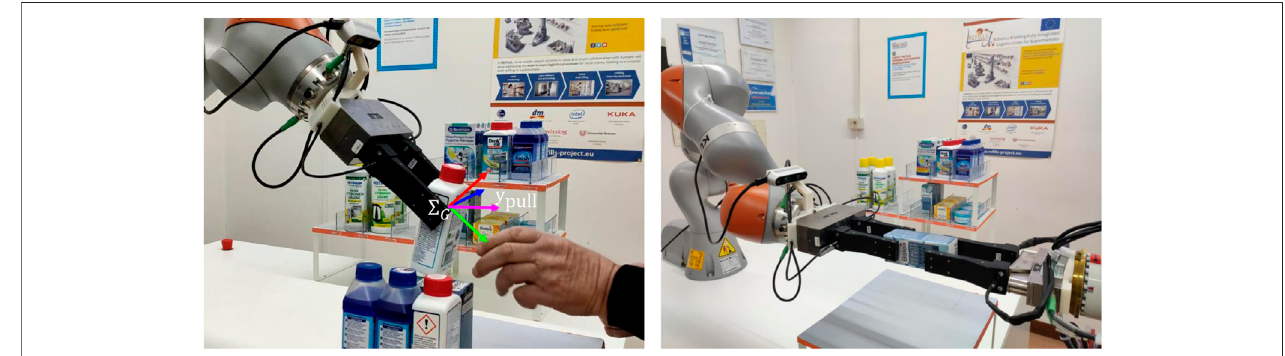
FIGURE 1 | Left picture: Experimental setup for the robot-to-human and human-to-robot handover, the frame (cid:1) G (in RGB convention) is the grasp frame, the magentaarrowrepresentsthepullingdirection y pull (de fi nedin Section3 ); Rightpicture: Experimentalsetupfortherobot-to-robothandover.Therobotontheleftisthe receiver and is equipped with an eye-in-hand camera to track the object to take. Both robots are endowed with force/tactile